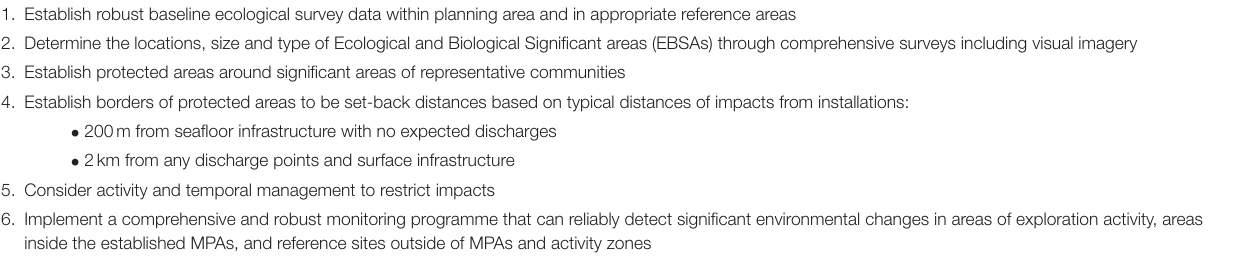
TABLE 4 | Recommendations for the spatial management of deep-sea ecosystems in the vicinity of oil and gas industrial